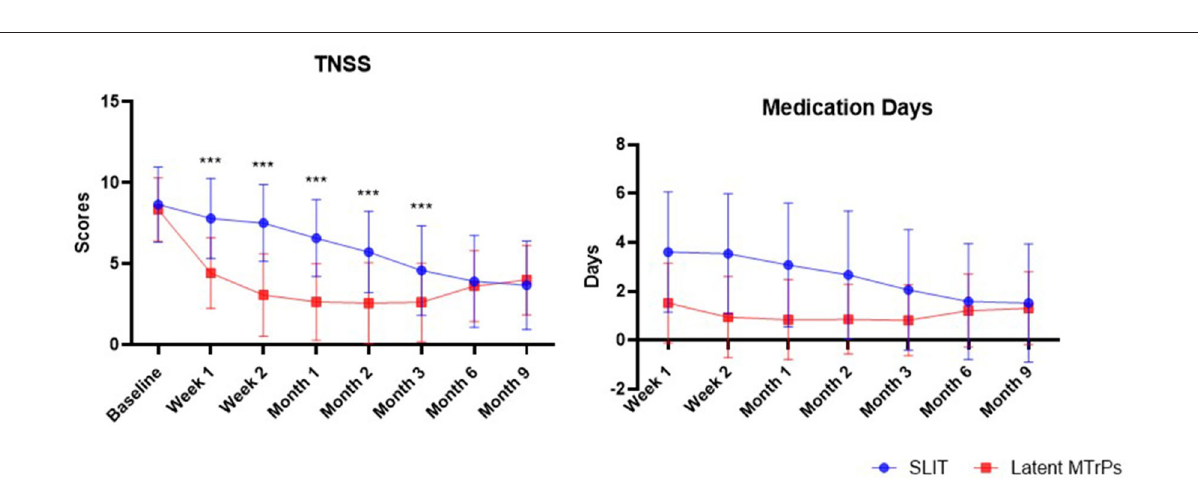
FIGURE 4 | The trend of the changes of TNSS and number days of rescue medication usage during the past week prior to the assessment points. TNSS, total nasal symptom